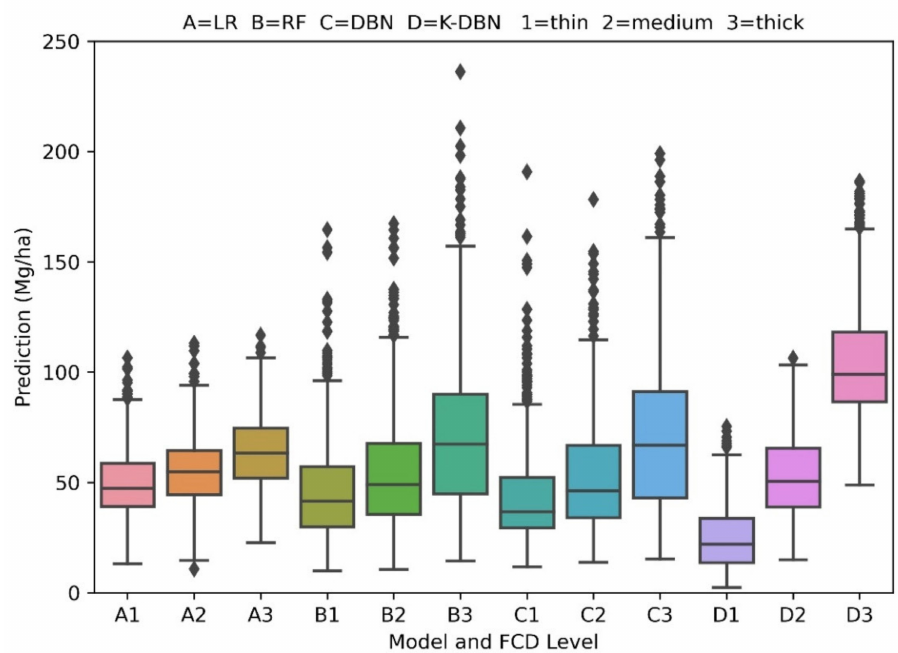
Figure 12. The AGB prediction results of each model at different FCD levels. In the two biomass ranges of <30Mg/ha and >80Mg/ha, the problems of low-value overestimation and high-value underestimation are obvious [21]. In order to accurately analyze the performance of each model in low-value overestimation and high-value un- derestimation, the prediction RMSE of the 526 low-value sample plots (AGB < 30) and 423 high-value sample plots (AGB > 80 Mg/ha) were analyzed, and the results are shown in Figure 13.